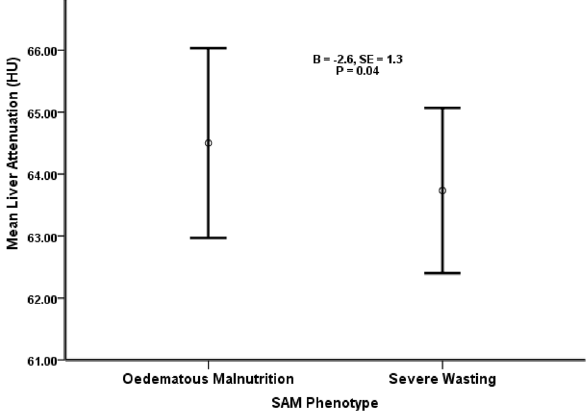
Figure 1. Regression of mean liver attenuation against SAM phenotype (adjusted for age, sex and birth weight) in 88 SAM survivors. The mean liver attenuation + SD as bars in Hounsfield units (HU) is shown for adult survivors of oedematous malnutrition and severe wasting.